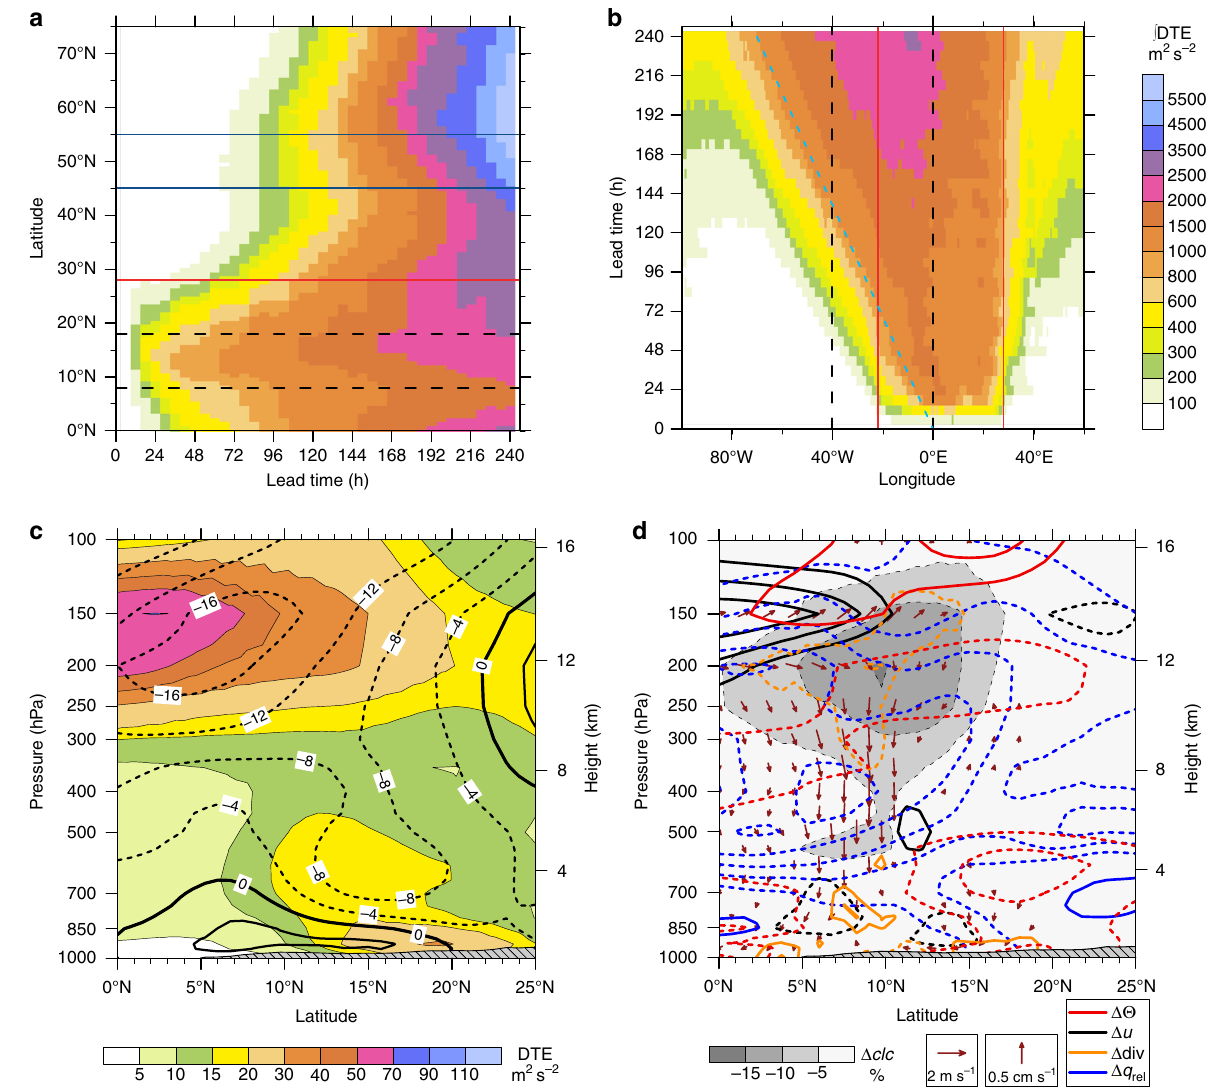
Fig. 4 Mechanism connecting West Africa and remote regions. a , b Hovmoeller diagrams of the difference total energy (DTE) between simulations explicitly resolving convection (EXPLC) and simulations employing the convection parameterisation (PARAM) vertically integrated from 1000 – 100 hPa and averaged from 40°W to 0°W ( a ) and from 8°N to 18°N ( b ). Dashed black lines mark the respective other averaging regions, red lines the borders of the two-way nesting domain and the light blue dashed line in b illustrates the westward propagation of the differences. The polar jet maximum lies between the two blue solid lines in a . c , d Vertical cross-sections averaged from 10°W to 10°E and over all 10 forecast days with hatched grey shading showing the orography: c DTE (shading) and zonal wind speed of PARAM (contour lines labelled in m s − 1 ); d differences (EXPLC − PARAM) in cloud cover ( Δ clc , shading, no positive values are visible because maximum difference is + 3%), meridional Δ v and vertical Δ w wind speed (vectors, only if | Δ v | >0.5 m s − 1 or | Δ w | >0.1 cms − 1 ), and as contour lines (positive solid, negative dashed) potential temperature ( ΔΘ , red: ±0.4 K intervals), zonal wind speed ( Δ u , black: ±1.5 m s − 1 intervals), divergence ( Δ div, orange: ±1.5 × 10 − 6 s − 1 intervals) and the relative difference (i.e. (EXPLC − PARAM)/PARAM) of speci fi c humidity ( Δ q rel , blue: ±5%